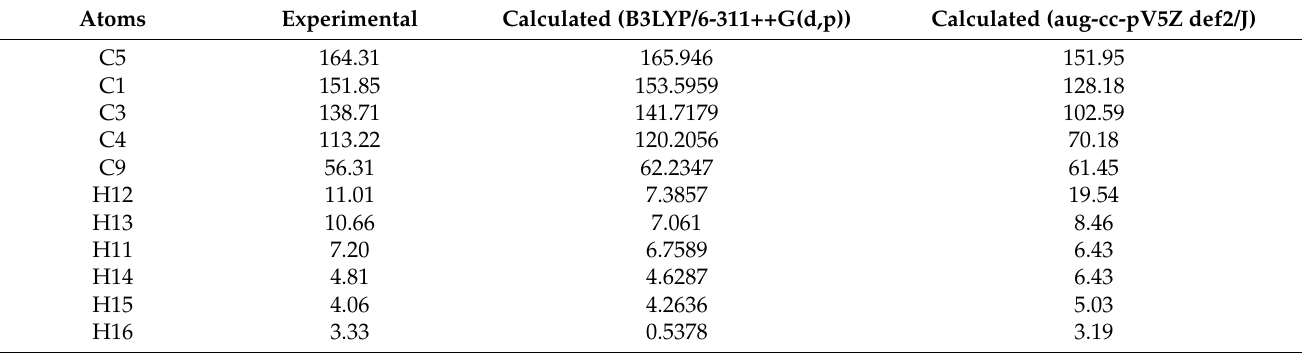
Table 3. Experimental and theoretical 13 C and 1 H chemical shift values (ppm) of 5-HMU in